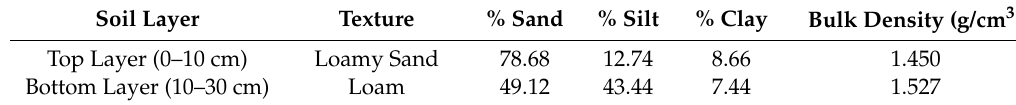
Table 1. Soil profile of plot area.